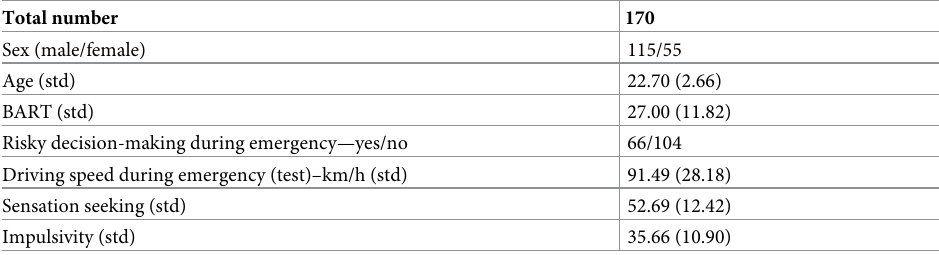
Table 1. Descriptive statistics of all